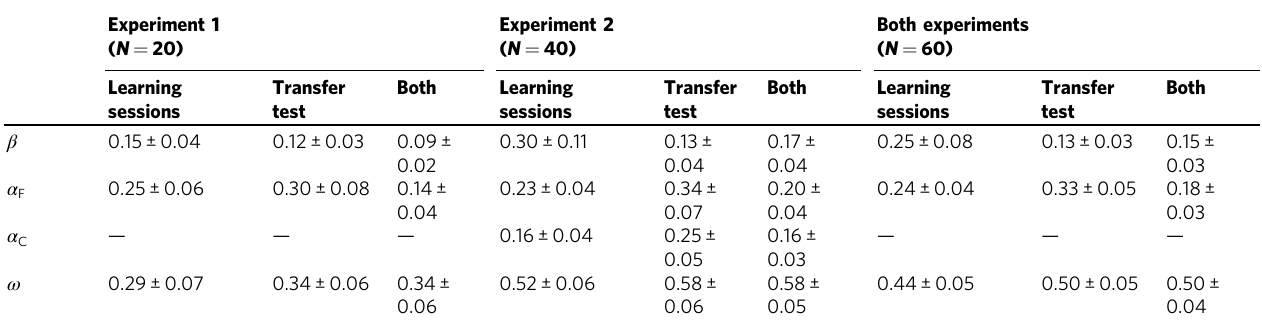
Table 4 Model parameters of the HYBRID model as a function of the dataset used for parameter optimization (learning sessions, transfer test or Both) and the computational